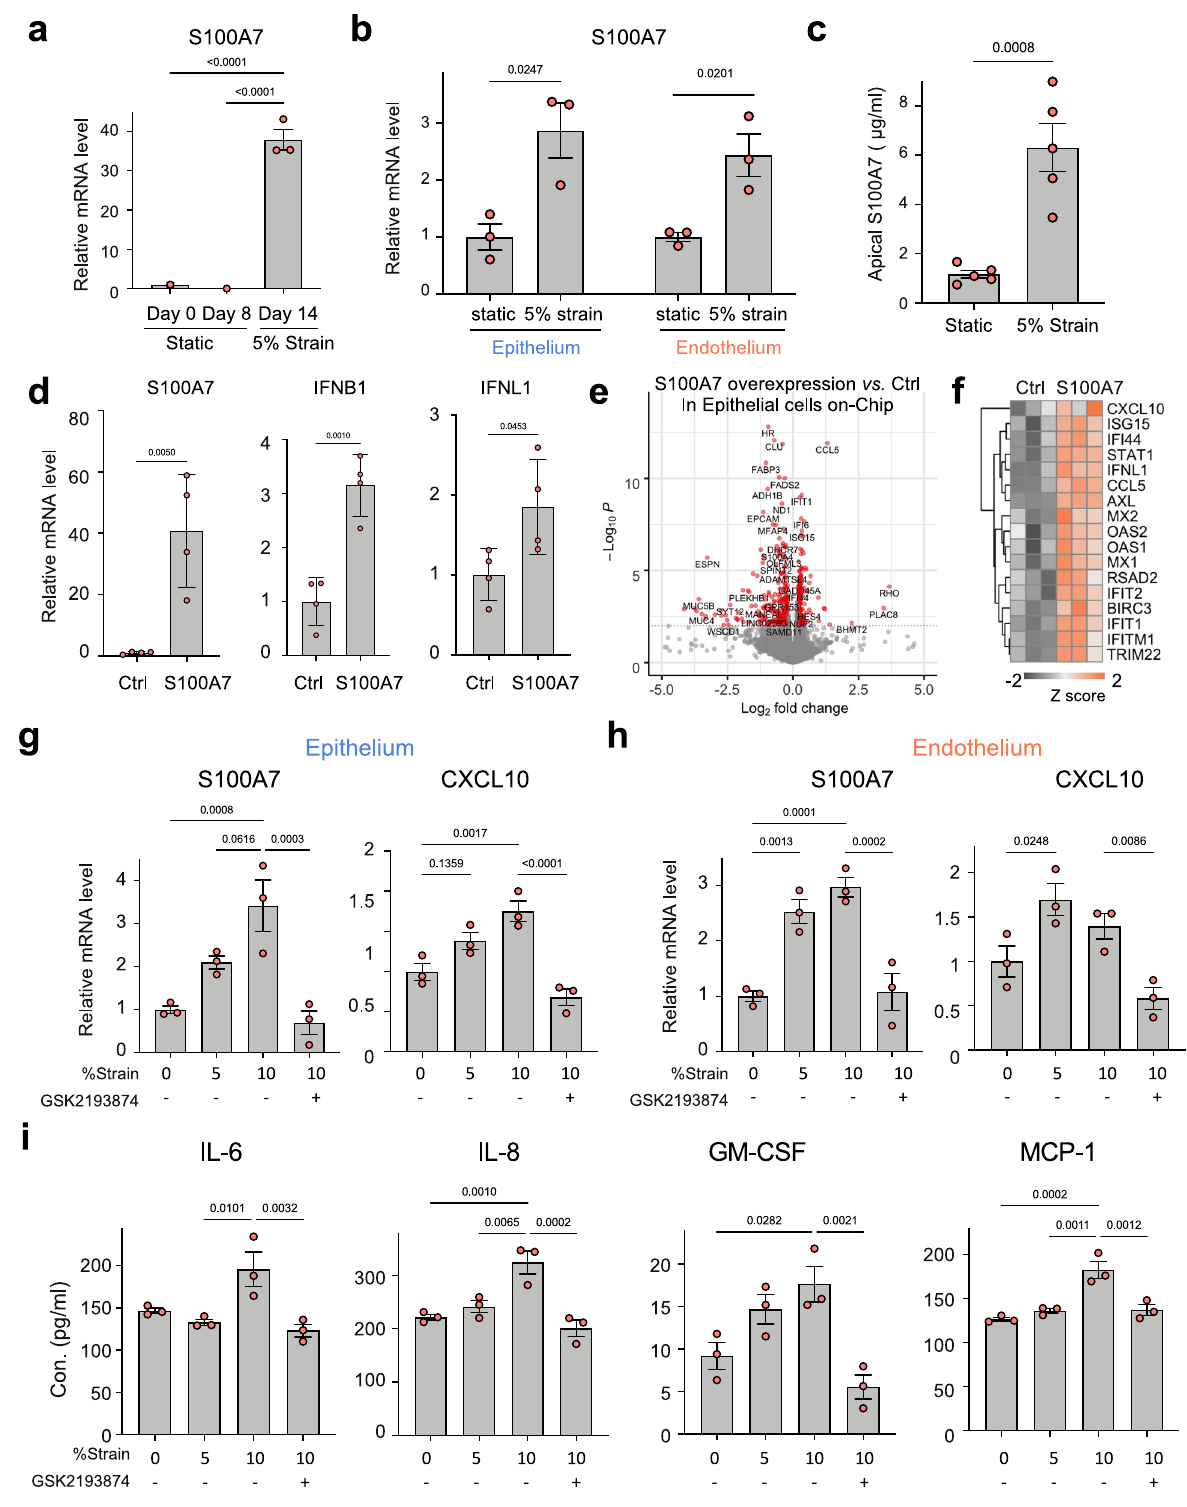
nephropathy, was perfused at its C max at 100 nM 47 through the vascular channel of human alveolus chips infected with H3N2 in fl uenza virus while exposed to cyclic physiological (5%) strain, it signi fi cantly blocked induction of multiple cytokines, including IL-6, IL-8, IP-10 and RANTES (Fig. 8c), and similar effects are produced using a different RAGE inhibitor drug (FPS-ZM1) (Supplementary Fig. 12a). Interestingly, treatment with 100 nM